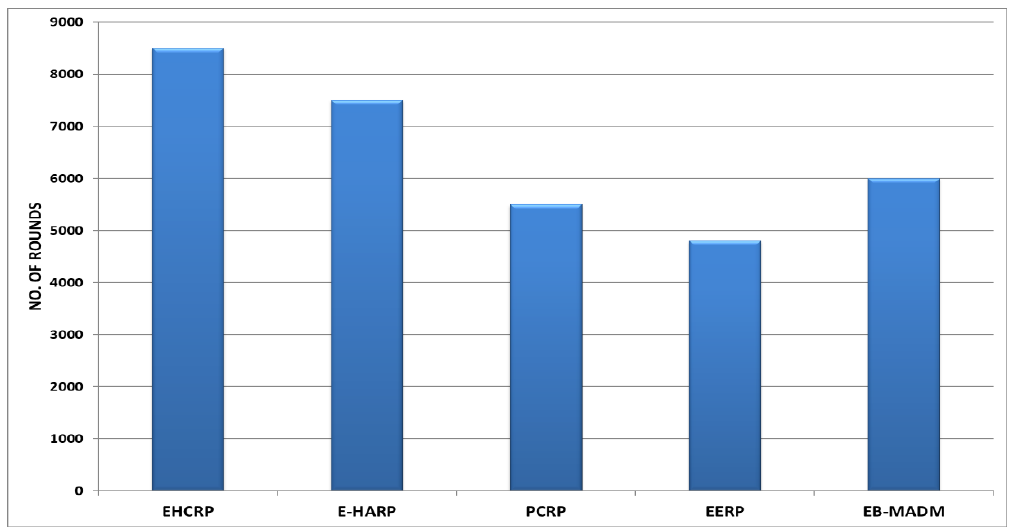
Figure 7. Breakdown of Network Stability (First-Node-Death).